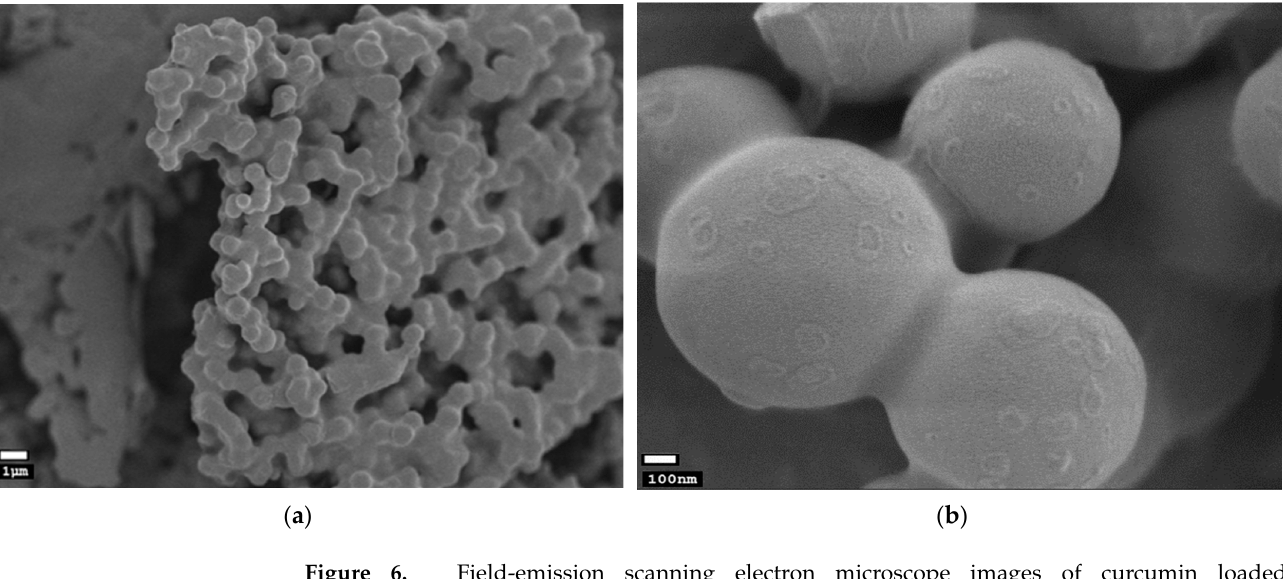
Figure 6. Field ‐ emission scanning electron microscope images of curcumin loaded chitooligosac ‐ Figure 6. Field-emission scanning electron microscope images of curcumin loaded charide–chondroitin sulfate ‐ nanoparticles with scale bars of ( a ) 1 um (×5000); and ( b ) 100 nm chitooligosaccharide–chondroitin sulfate-nanoparticles with scale bars of ( a ) 1 µ m ( × 5000); and (×50,000). ( b ) 100 nm ( ×